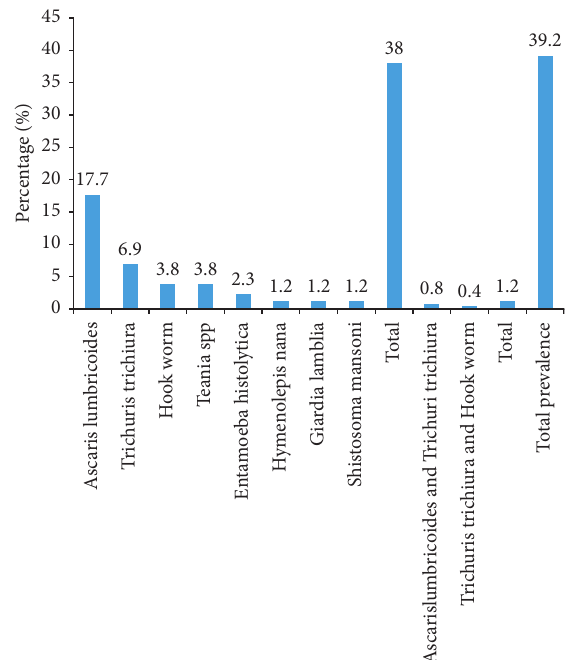
Figure 1: Distribution of intestinal parasites among street food handlers in Jimma town, Southwest Ethiopia ( n � 260), Oct–Dec